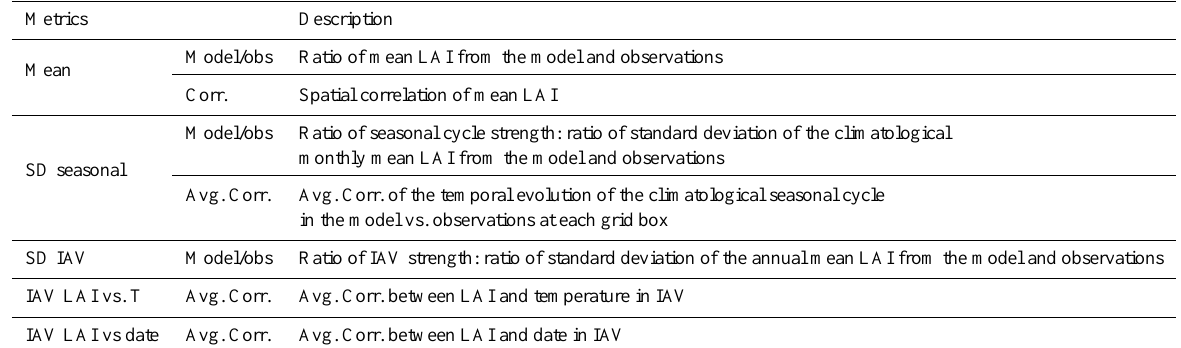
Table 2. Table of metrics for LAI comparisons between model and observation used in the following tables. More description of these metrics are provided in Sect. 2.4.